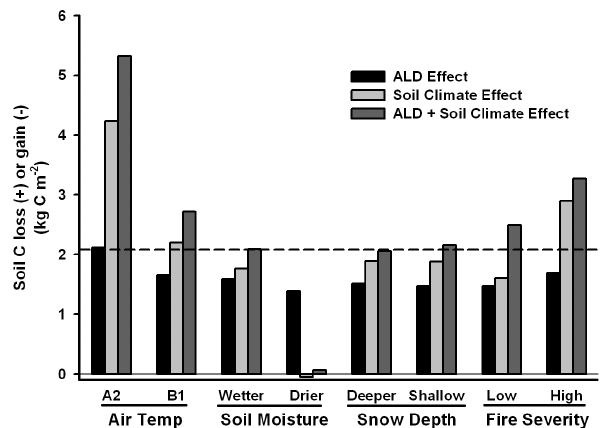
Fig. 8. The effects of combined climate/fire factors on soil C stor- age. The three scenarios reflect reduced fire severity associated with warmer and wetter soil conditions, higher fire severity associated with warmer and drier conditions, and longer snow-free season as- sociated with warmer air temperatures. The ALD and soil climate parameterizations were derived from GIPL output as illustrated in Fig. 6. The dashed line represents total OC losses (ALD+soil climate) when present-day climate conditions (with no changes in snow, moisture or fire) were run for 3 fire